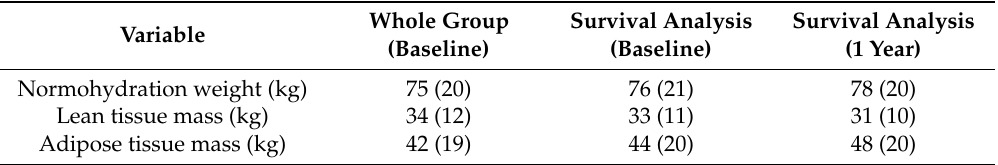
Table 2. Characteristics of those patients involved in the primary analysis (whole group) and secondary analysis (survival group).